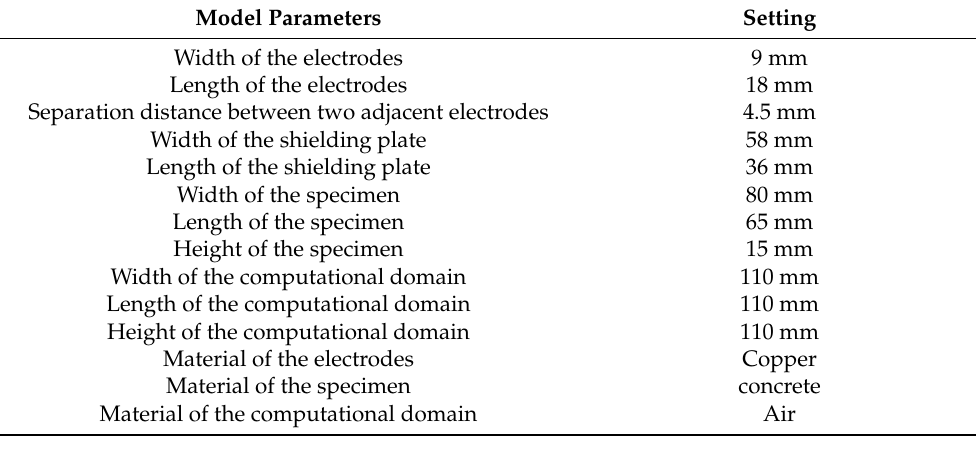
Table 1. Summary of the numerical model specification.